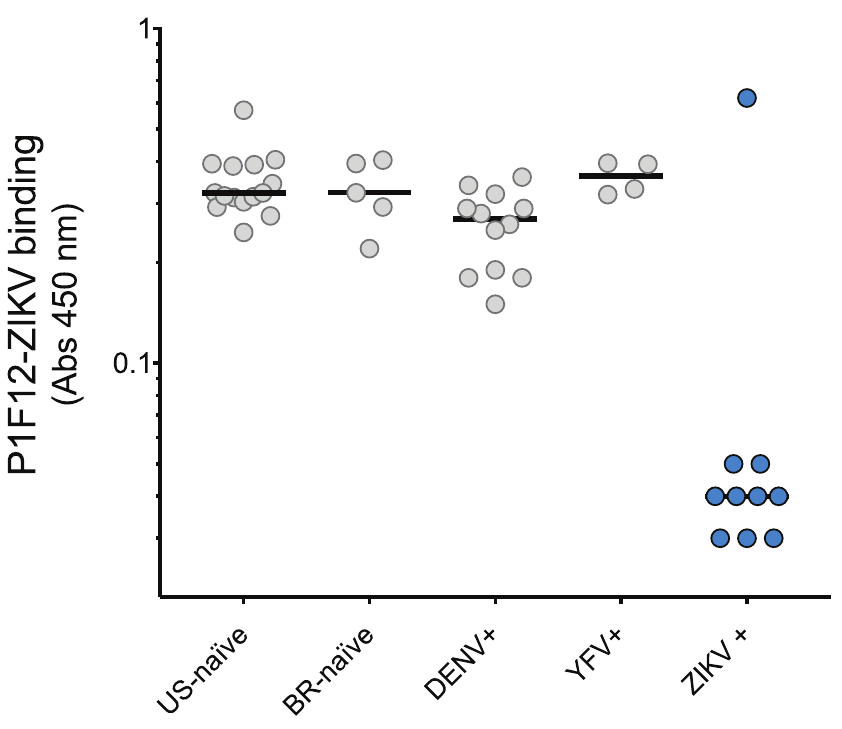
Fig 5. Inhibition of ZIKV-P1F12 binding discriminates plasma from ZIKV and DENV exposures. A modifiedvirus capture ELISA was conductedto assess the ability of plasma from 46 individualsto block the bindingof P1F12 to whole ZIKV. CapturedZIKV was incubatedwith 1/10 dilutedplasma from na ï ve(US and Brazil) and DENV+, YFV+ or ZIKV+ volunteers prior to additionof purifiedP1F12. Viral infectionwas determined by RT-PCR. ZIKV-boundP1F12 was detected using an HRP-conjugated secondaryAb specific for the rhesus IgG1 Fc regionof recombinant P1F12. ZIKV+ (blue circles), but not ZIKV- (gray circles) plasma inhibitedbindingof P1F12 mAb to